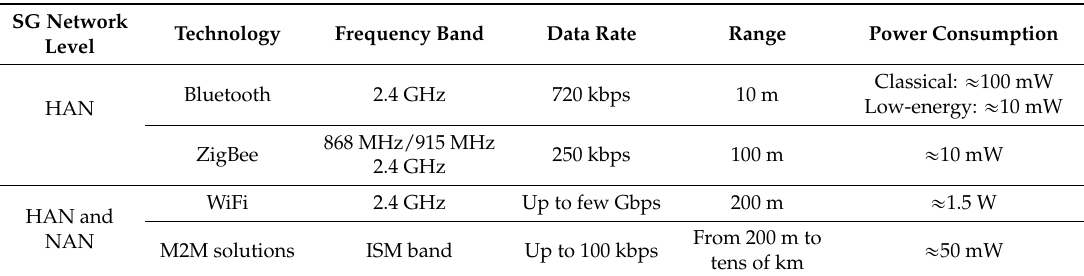
Table 2. Comparison of the main characteristics of the Home Area Network (HAN) and Neighborhood Area Network (NAN) communication solutions.